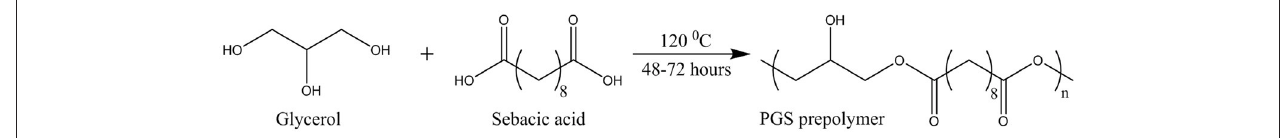
FIGURE 1 | Synthesis of PGS prepolymer by melt-polycondenzation.